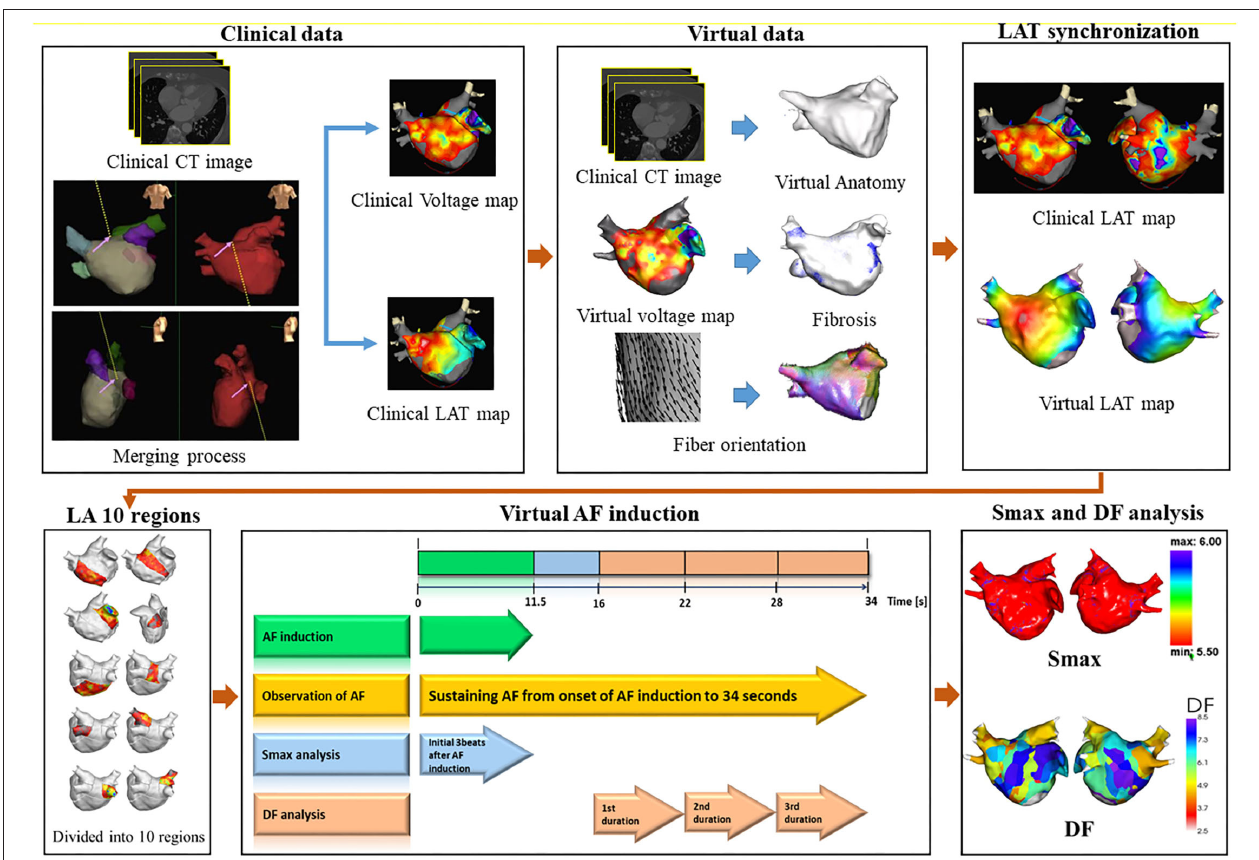
FIGURE 1 | Study protocol of computational atrial modeling. CT, computed tomography; LAT, local activation time; LA, left atrium; AF, atrial fibrillation; Smax, the maximal slope of action potential restitution curve; DF, dominant frequency.